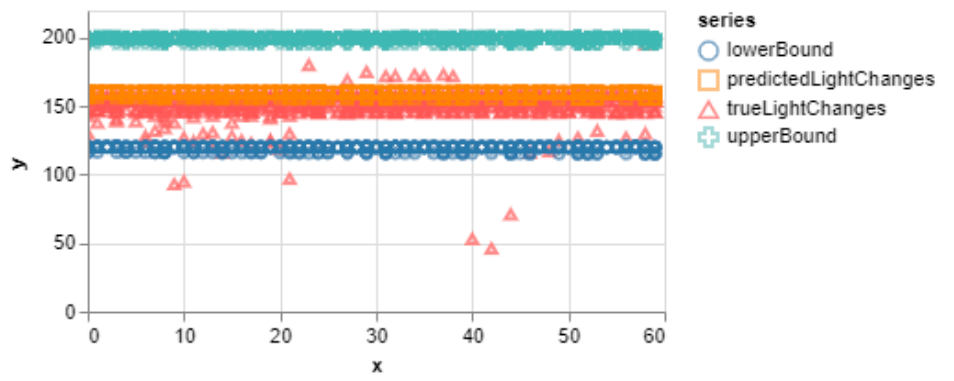
Figure 5. Result of the test dataset for the default model. The x-axis represents the time (sec) while the y-axis is the light intensity in Lux.